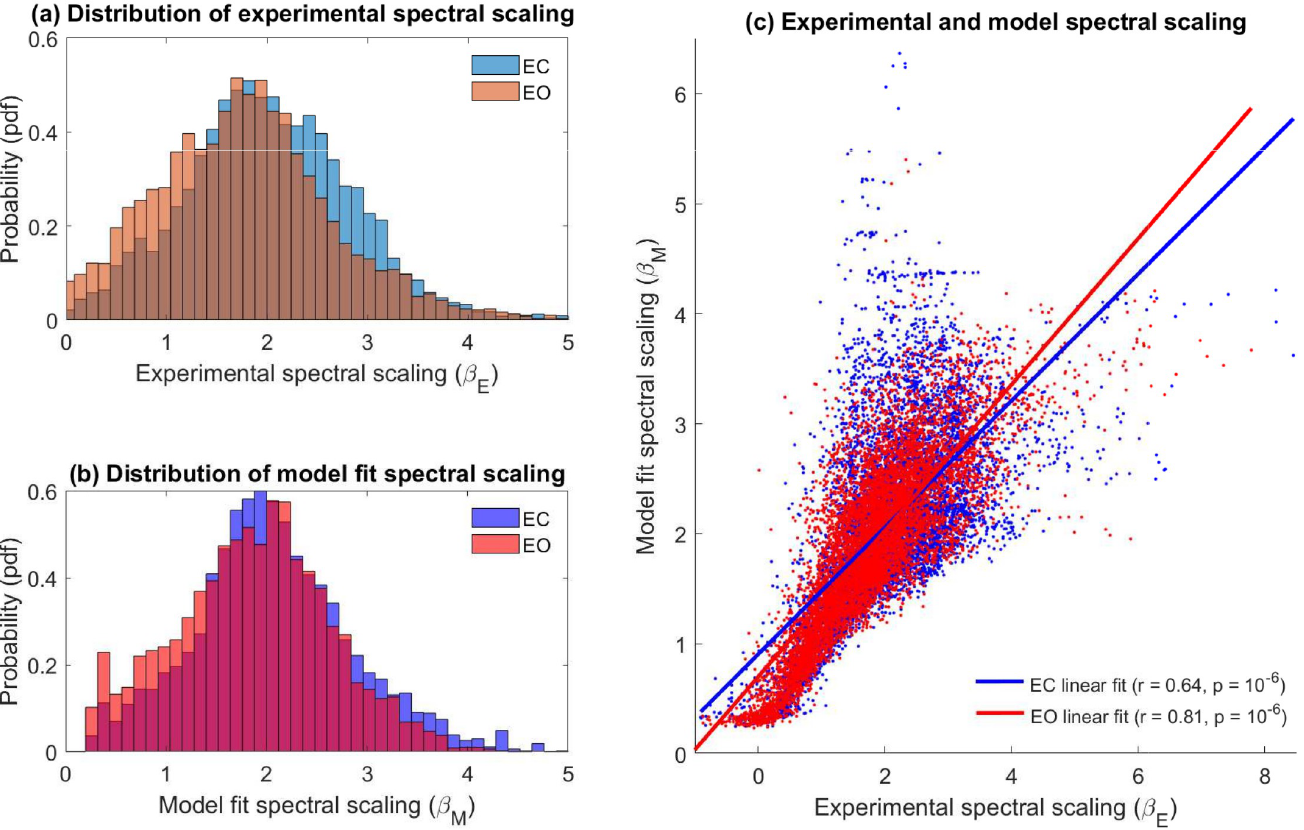
Fig 5. Experimental and model spectral scaling in EC and EO states. (a) Probability distribution of experimental spectral scaling exponent ( β ) for EC (blue) and E EO (red) states with data set 1 and 2 pooled for analysis. (b) Same as (a) but for optimal model fit spectral scaling exponent ( β M ). (c) Scatter plot of the experimentally determined spectral scaling parameter ( β ) versus the model calculated spectral scaling parameter ( β ) for EC (dots—blue) and EO resting state (dots—red). The E M experimental and model fit scaling parameters are well correlated across both recording conditions (EC: r = 0.64, p = 10 − 6 / EO: r = 0.81, p = 10 − 6 ). Statistical significance calculated via a nonparametric permutation